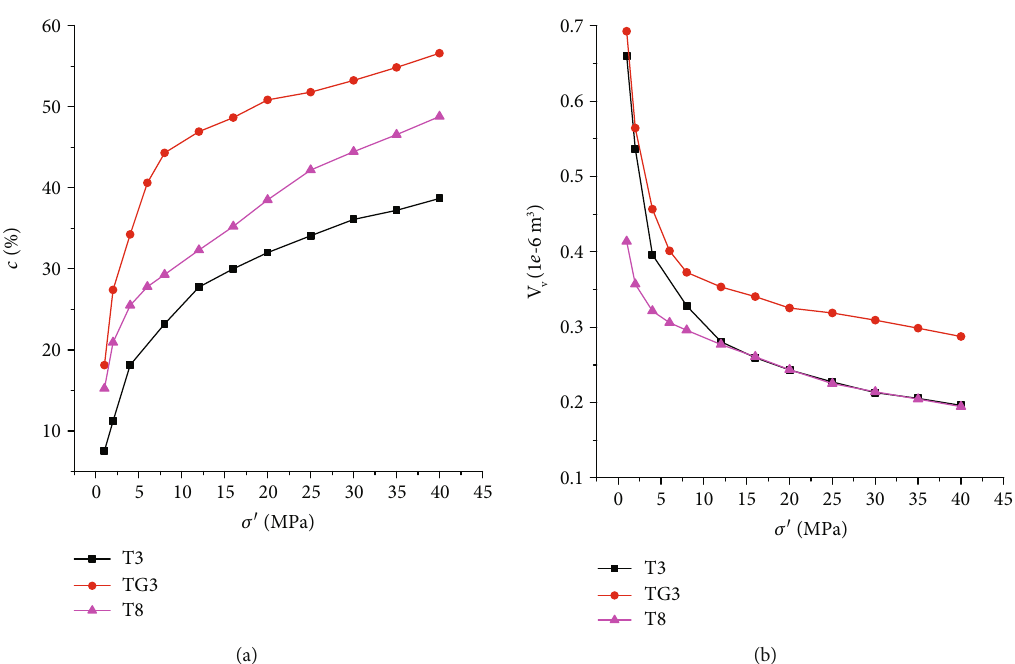
Figure 14: (a) Contact ratio and (b) void space of di ff erent samples under di ff erent e ff ective con fi ning stress conditions.